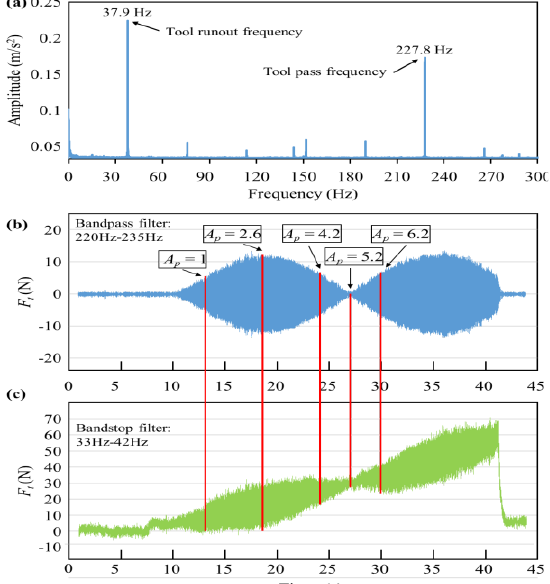
Figure 10. Experiment result and force fluctuation data: ( a ) FFT analysis at spindle speed 2279.8 rpm, A e = 2.5 mm, A p = 0~10 mm; ( b ) milling force fluctuation data at tool pass frequency and ( c ) milling force data without cutter runout